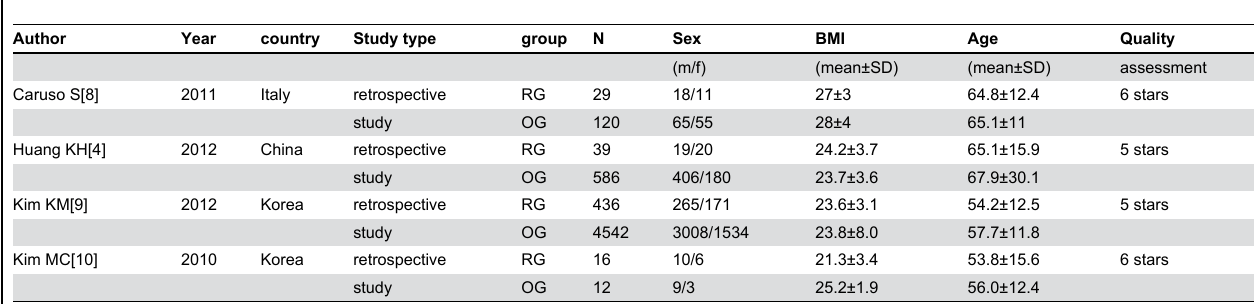
Table 1. Baseline characters of include studies and quality assessment (mean ±